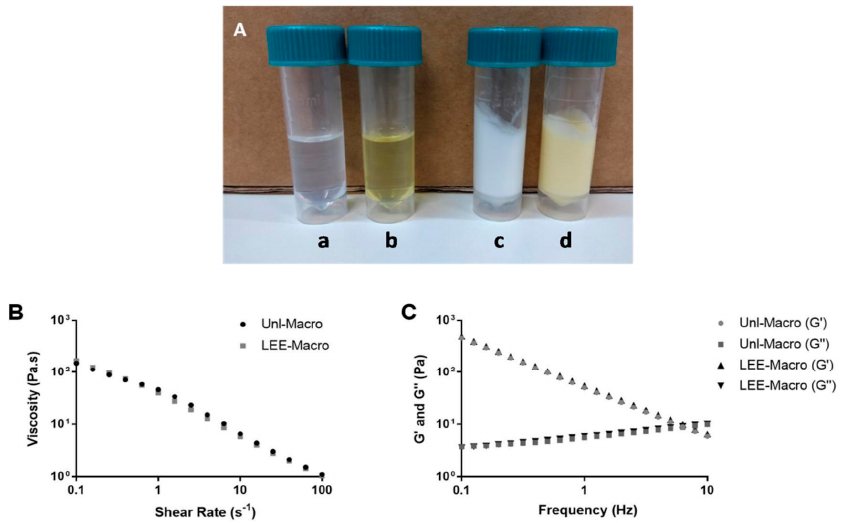
Figure 4. ( A ) Photograph images of ME and macroemulsions: Unl-ME (a), LEE-ME (b), Unl-Macro (c) and LEE-Macro (d); ( B ) Effect of shear rate on apparent viscosity of macroemulsions; ( C ) Effect of oscillation frequency sweep test in the G’ and G’’ in